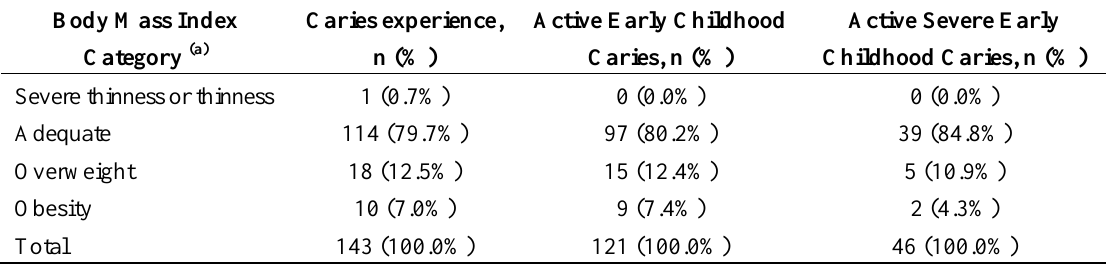
Table 2. The frequency of BMI categories among children according to their dental caries status ( i.e. , caries experience, active ECC or active S-ECC).